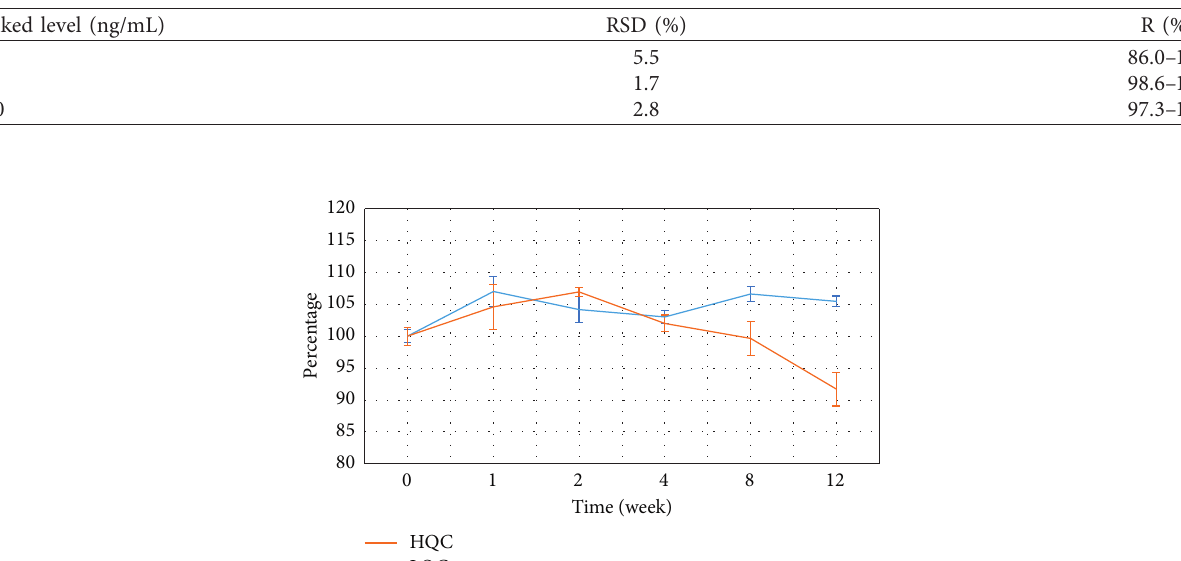
Figure 3: The calibration curve of progesterone on blank matrix. Table 2: Repeatability and recovery of progesterone at different levels.